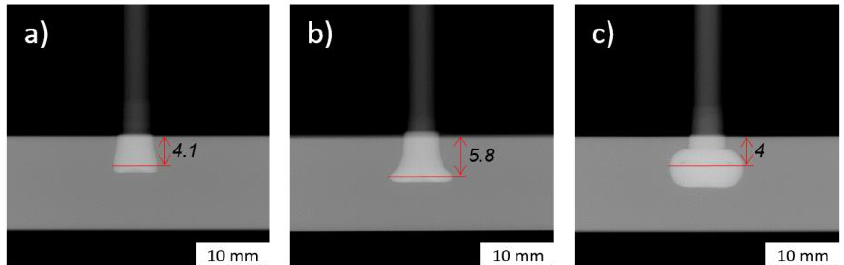
Figure 20. Friction force direct effect on Dp: ( a ) Condition 33 (RS = 19,000 rpm; FT = 1.8 s; FoT = 1.5 s; FF = 1500 N; FoF = 4500 N); ( b ) Condition 25 (RS = 19,000 rpm; FT = 1.8 s; FoT = 1.5 s; FF = 2500 N; FoF = 4500 N); and ( c ) Condition 34 (RS = 19,000 rpm; FT = 1.8 s; FoT = 1.5 s; FF = 3500 N; FoF = 4500 N).